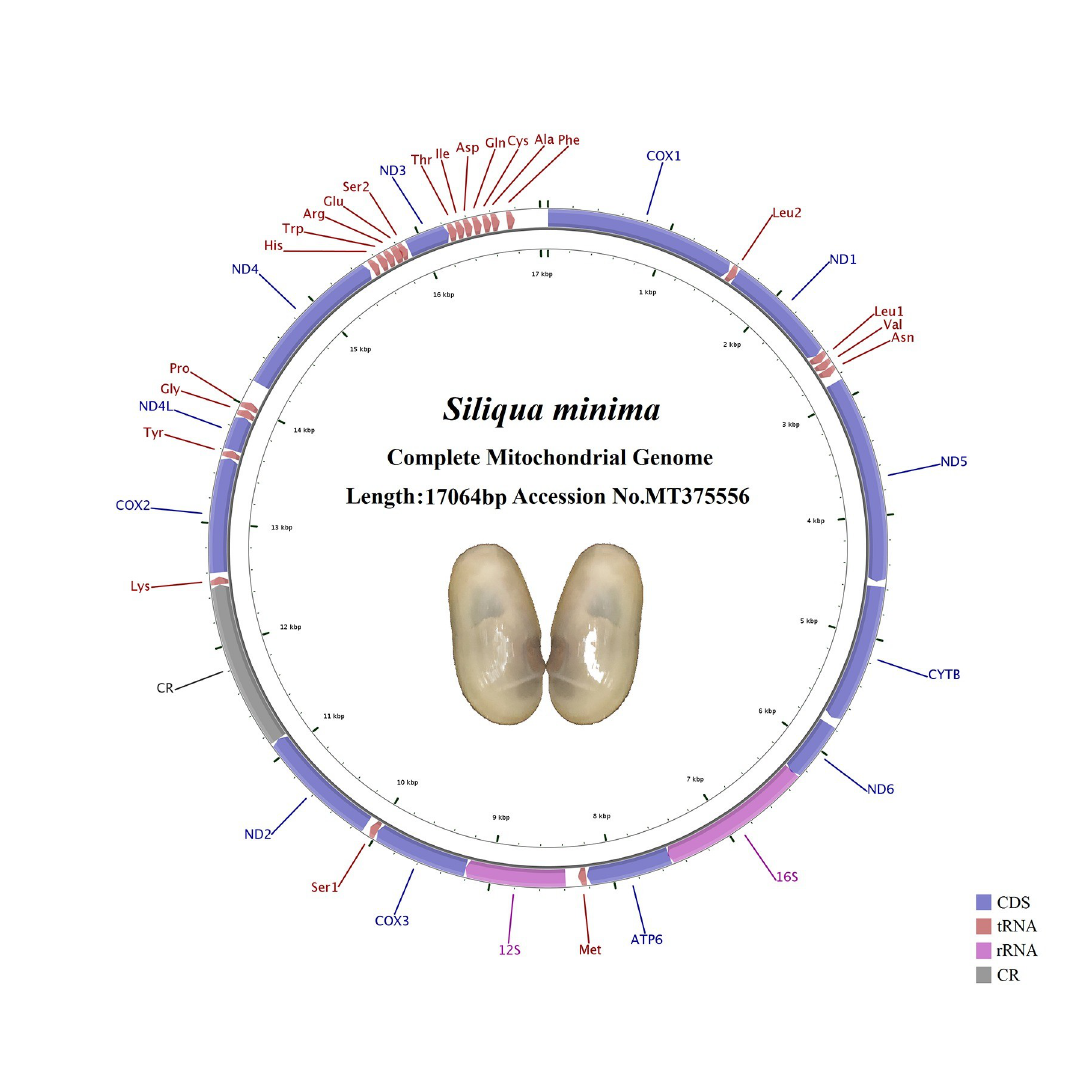
Fig 1. Maps of the mitochondrial genomes of Siliqua minima . Direction of gene transcription is indicated by the arrows. https://doi.org/10.1371/journal.pone.0249446.g001 PLOS ONE | https://doi.org/10.1371/journal.pone.0249446 April 6,